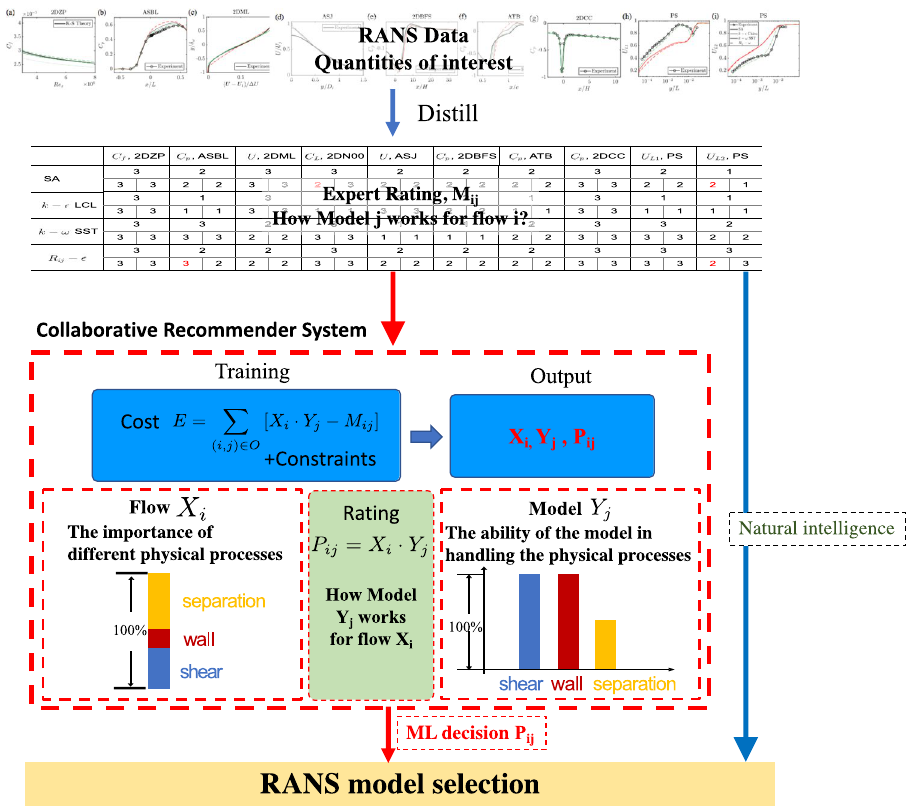
Figure 1. A sketch of the decision making process. The proposed approach is as follows. First we generate expert rating of the RANS results, M ij , which describes how well model j works for flow i .. Second, we apply collaborative filtering to train a recommender system. The recommender system will learn how much different physical processes control flow i , i.e., X i , and how well model j handles these physical processes, i.e., Y j . The trained recommender system will predict a rating P ij = X i · Y j , which describes how model j works for flow i . Finally, a decision can be made using P ij